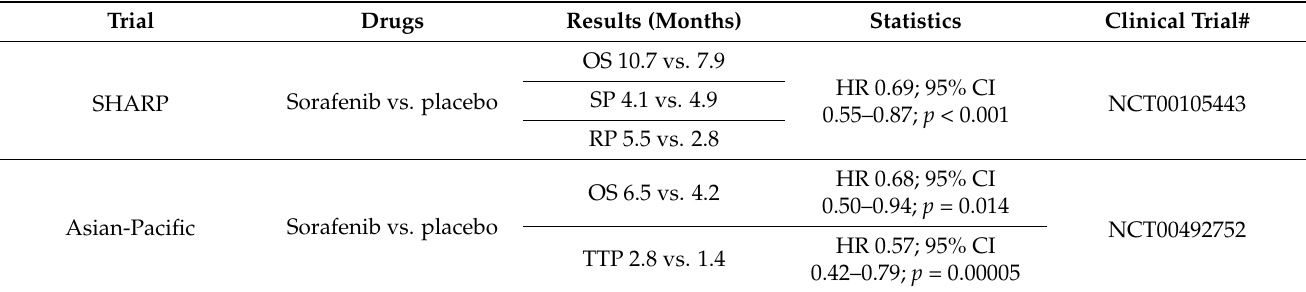
Table 1. Summary of significant clinical trials for current first-line systemic treatment options of advanced HCC. Trial Drugs Results (Months) Statistics Clinical Trial#